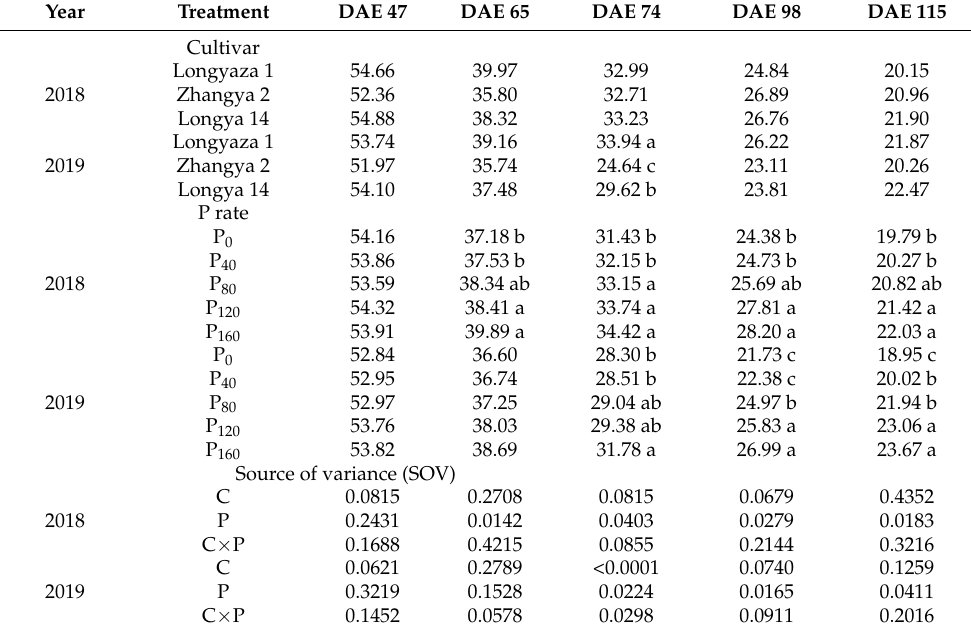
Table 6. Shoot N concentration (g kg − 1 DM) at Yongdeng in 2018 and 2019 with three cultivars flax and five phosphorus